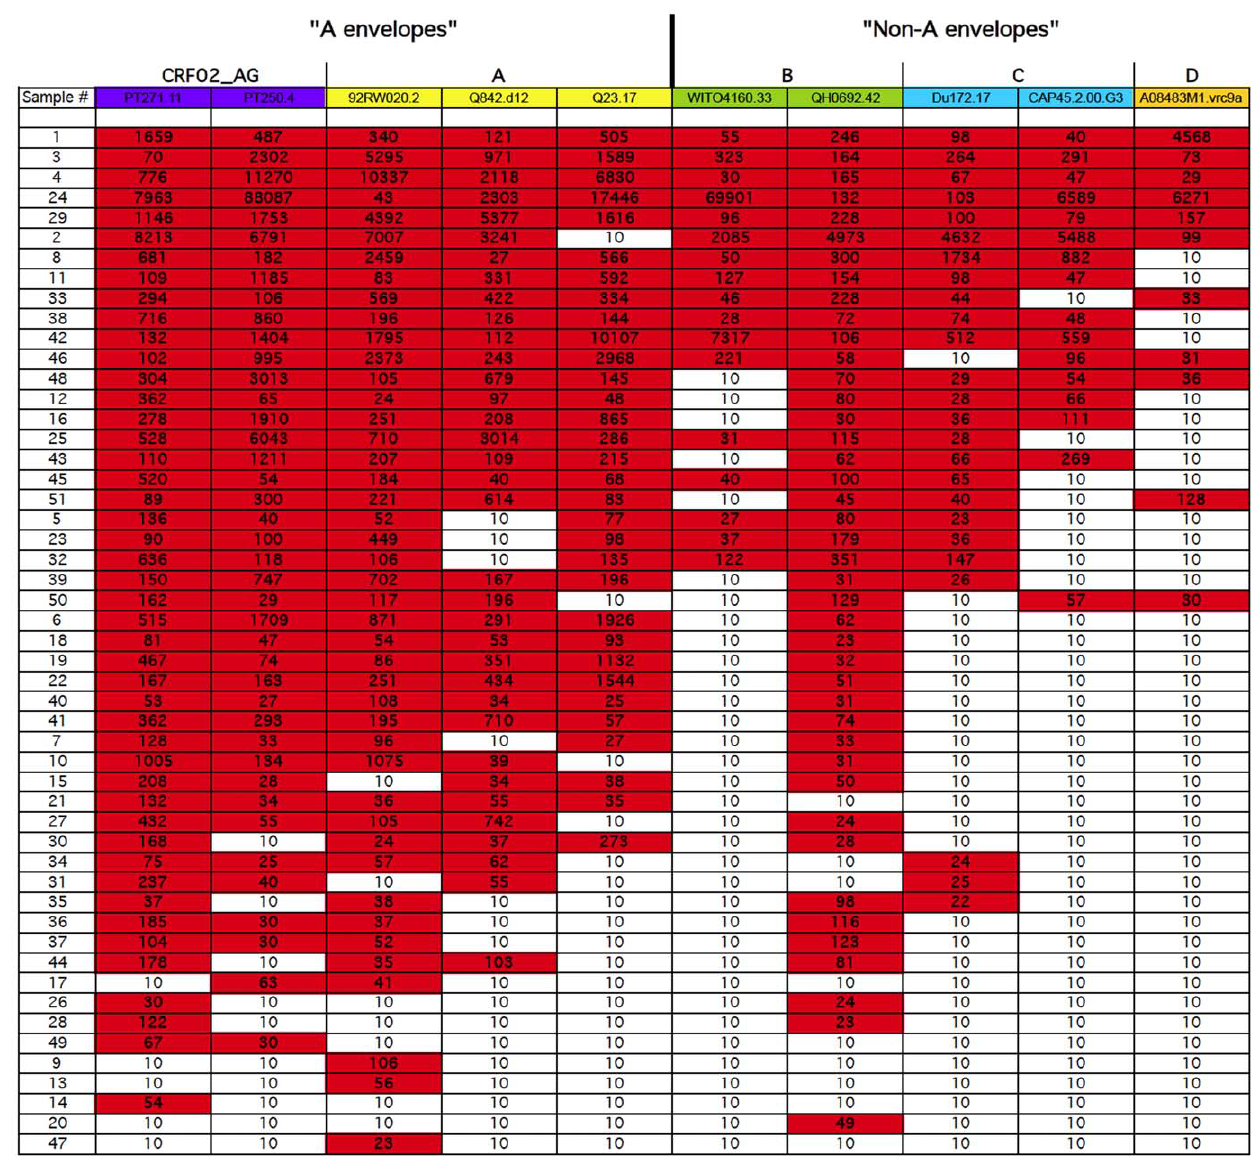
Figure 4. Breadth of neutralization in HIV-1 subtype A infected patient sera. Shown is the breadth of neutralization for each serum sample against a panel of 10 pseudoviruses from five different subtypes (Purple columns=subtype CRF02_AG, yellow=subtype A, green=subtype B, blue=subtype C and orange=subtype D). Red boxes indicate ID 50 s . 10 (positive neutralization). HIV-1 subtype A infected subjects showed more frequent neutralization against subtypes CRF02_AG and A, as compared to non-A subtypes (p , 0.001, Fisher’s exact